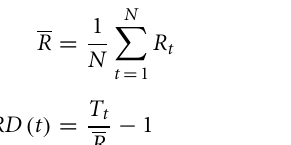
at electrode C4 was translated into visual feedback. Event-related desynchronization of mu-rhythms (9–15Hz, mu-ERD) was indicated by upward movements of a blue ball, while mu-event-related synchronization was indicated by downward movements (mu-ERS). Participants were instructed to keep the ball above the dotted horizontal line during the task to hit the target (indicated by red